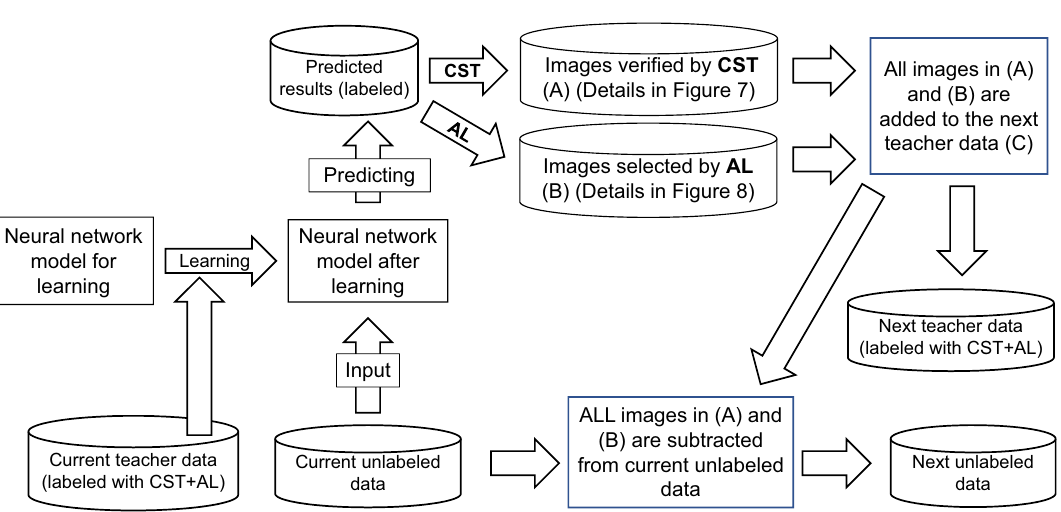
Figure 9. Semi-supervised learning process with the confirmed self-training and active learning (CST + AL) method. Two semi-supervised learnings, CST and AL, were performed in parallel using the same predicted labeled results. With the threshold and criteria adopted in this study, the same image was never selected as an additional candidate by both methods. All labeled images picked by both methods were added to the next set of teacher data. Then, they were subtracted from current unlabeled data to create the next set of unlabeled data. The rectangular frame shows automatic processing by a hand-made program written in